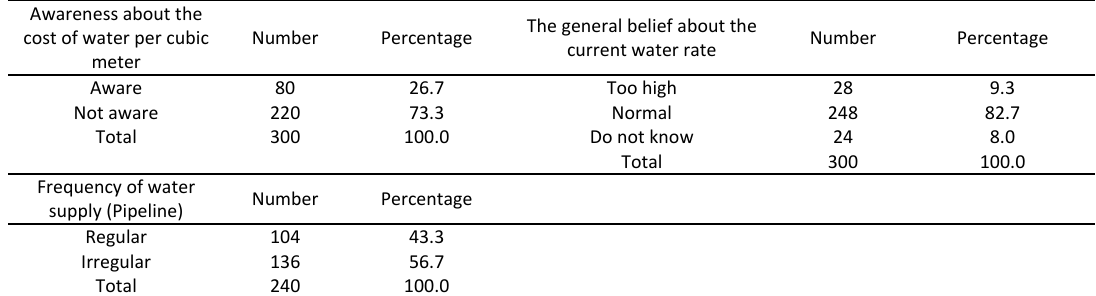
Table 5: Awareness of water management